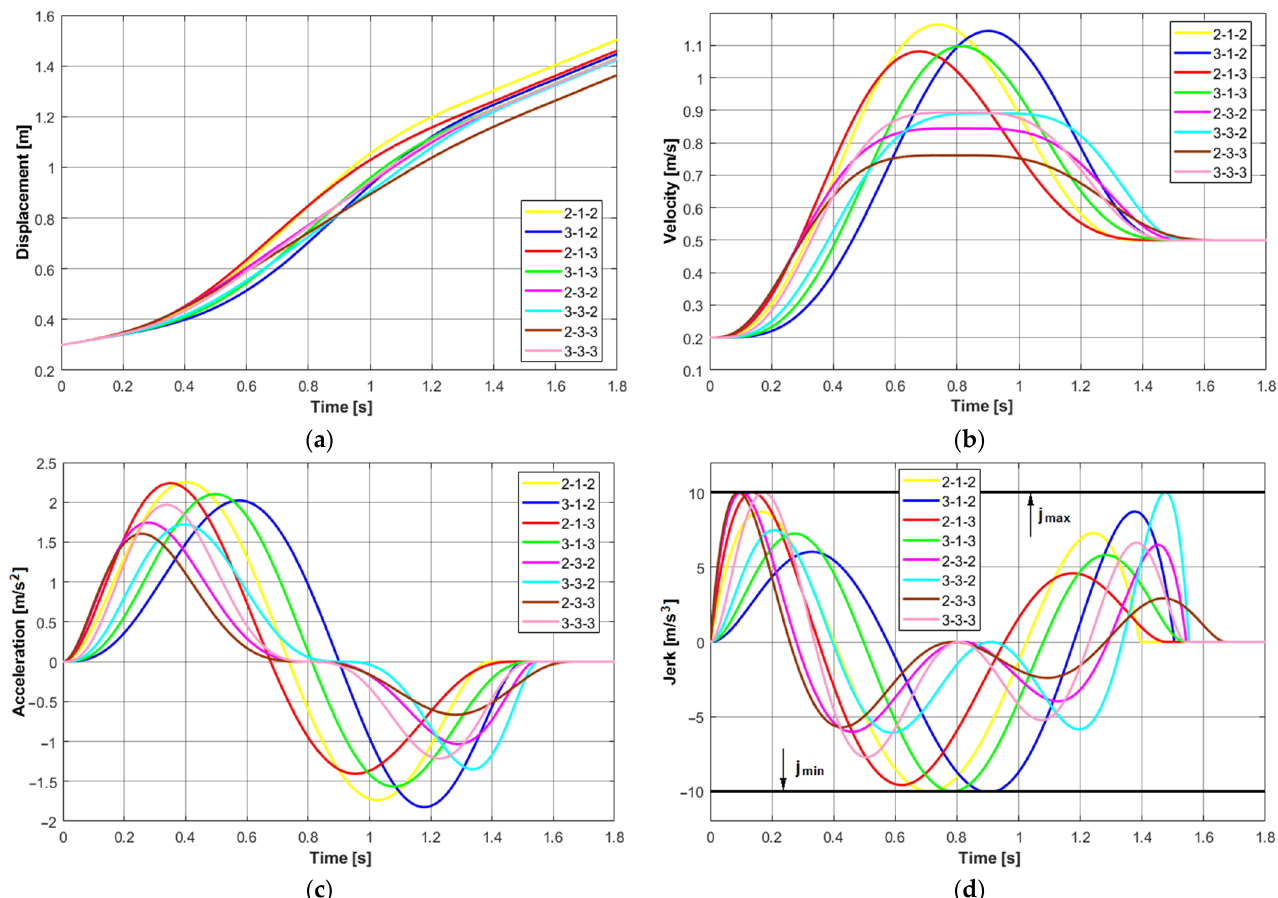
Figure 3. Profiles of kinematic quantities for the trajectories with the jerk constraint: ( a ) displacement; ( b ) velocity; ( c ) acceleration; ( d ) jerk.